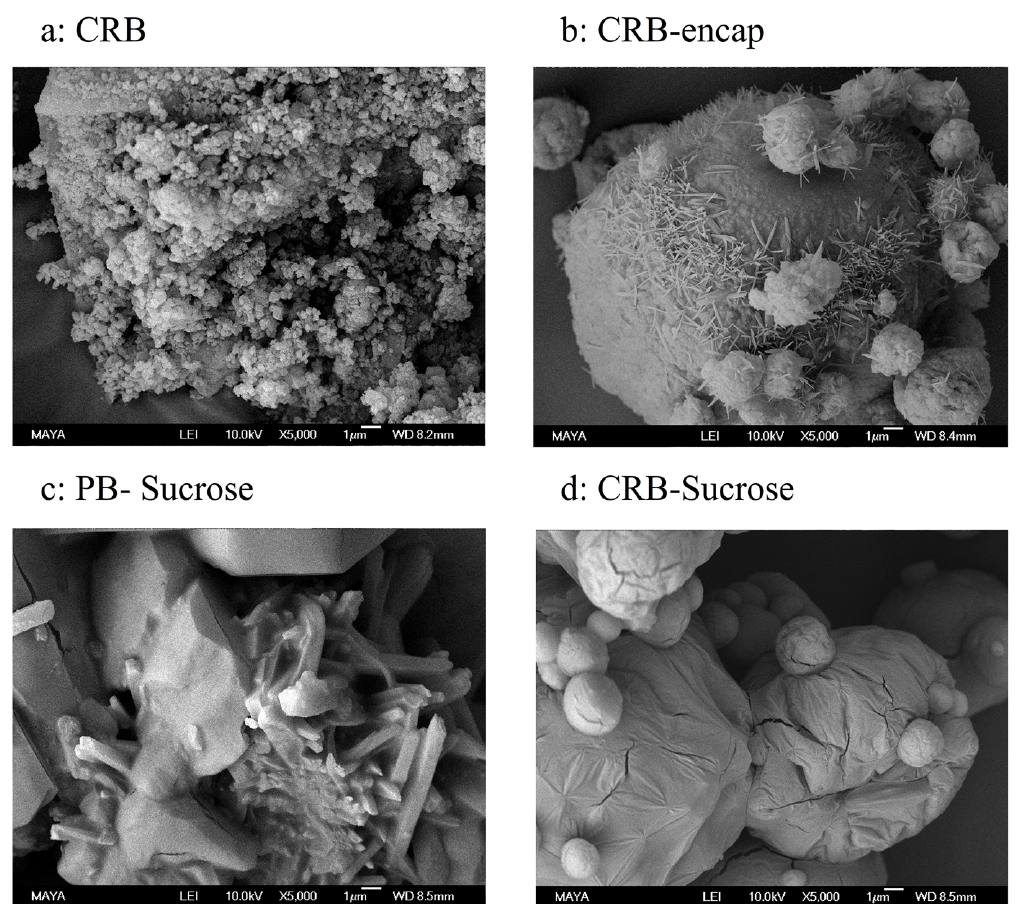
Figure 3. SEM images of ( a ) CRB: Carbohydrates rich bixin extract prior spray drying; ( b ) CRB-encap: Microcapsules of spray dried CRB extract; ( c ) CRB-Sucrose: Microcapsules of spray dried CRB